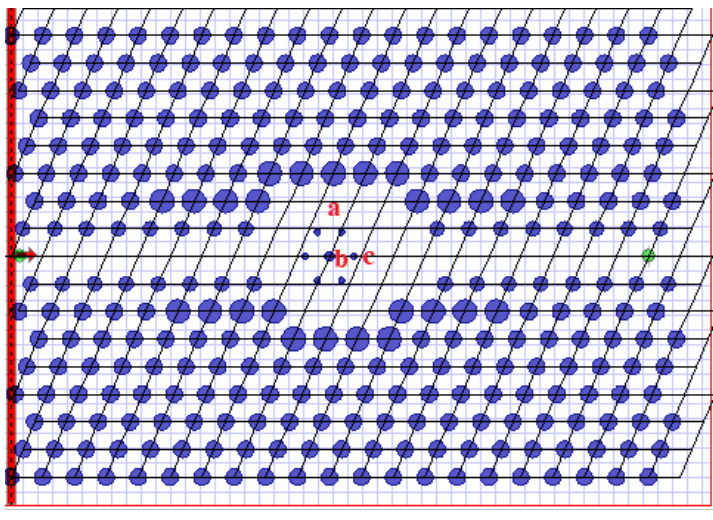
Figure 4. Design structure for detection of water concentration in